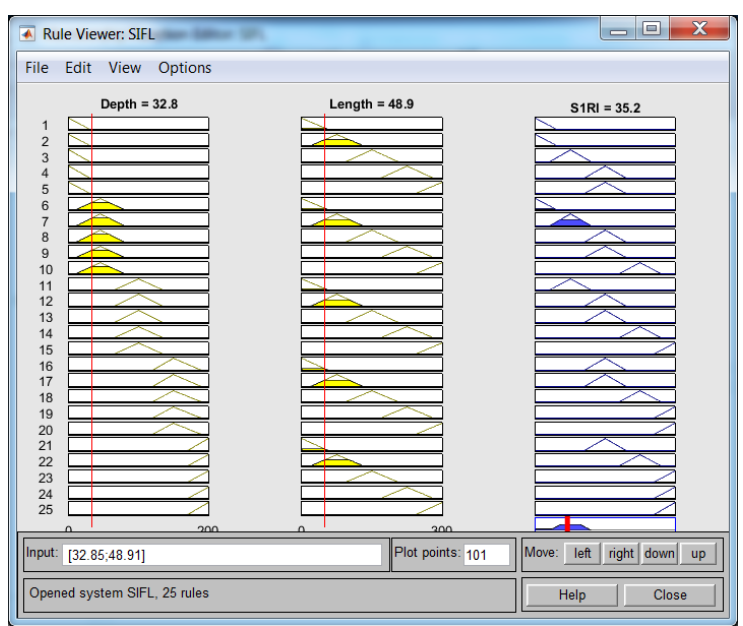
Figure 5. Rule viewer of FIS_1.